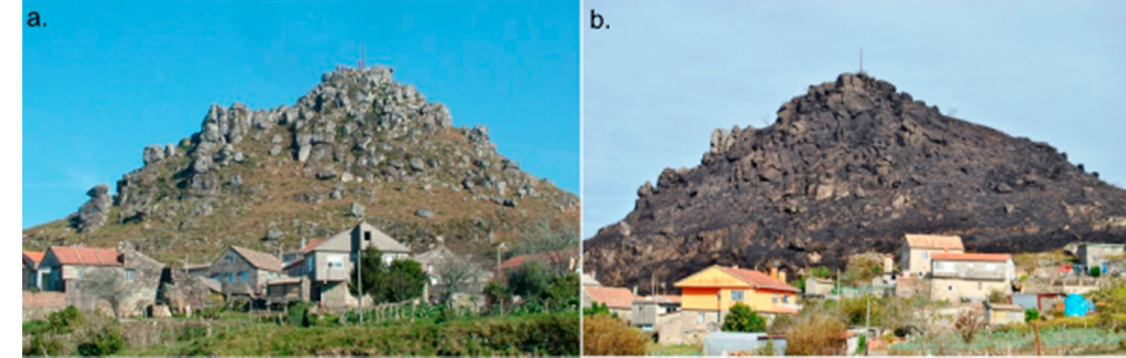
Figure 8. Two views of the study area: ( a ) before and ( b ) after the occurrence of the wildfire in 2017 (photos taken by the authors).